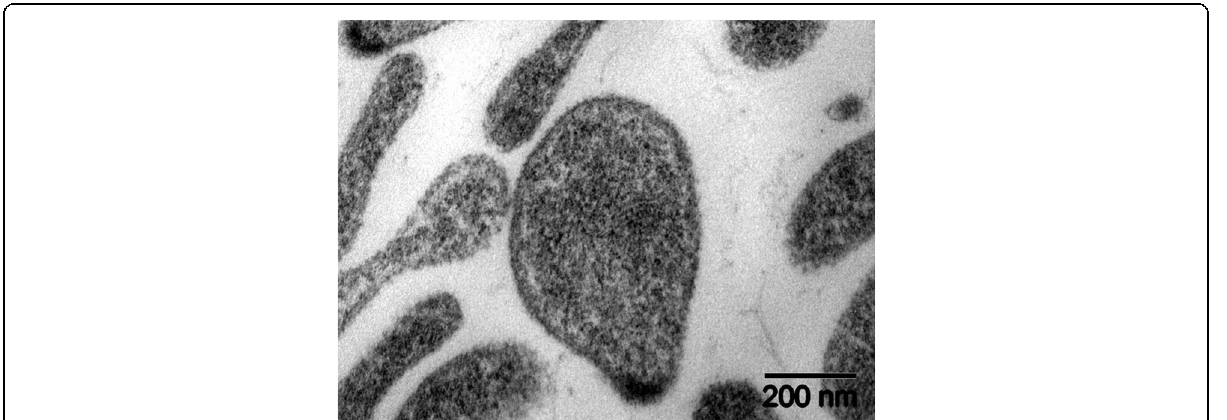
Fig. 1 Transmission electron micrograph of thin section of Mycoplasma testudineum strain BH29 T . Image from ref. [3], reproduced